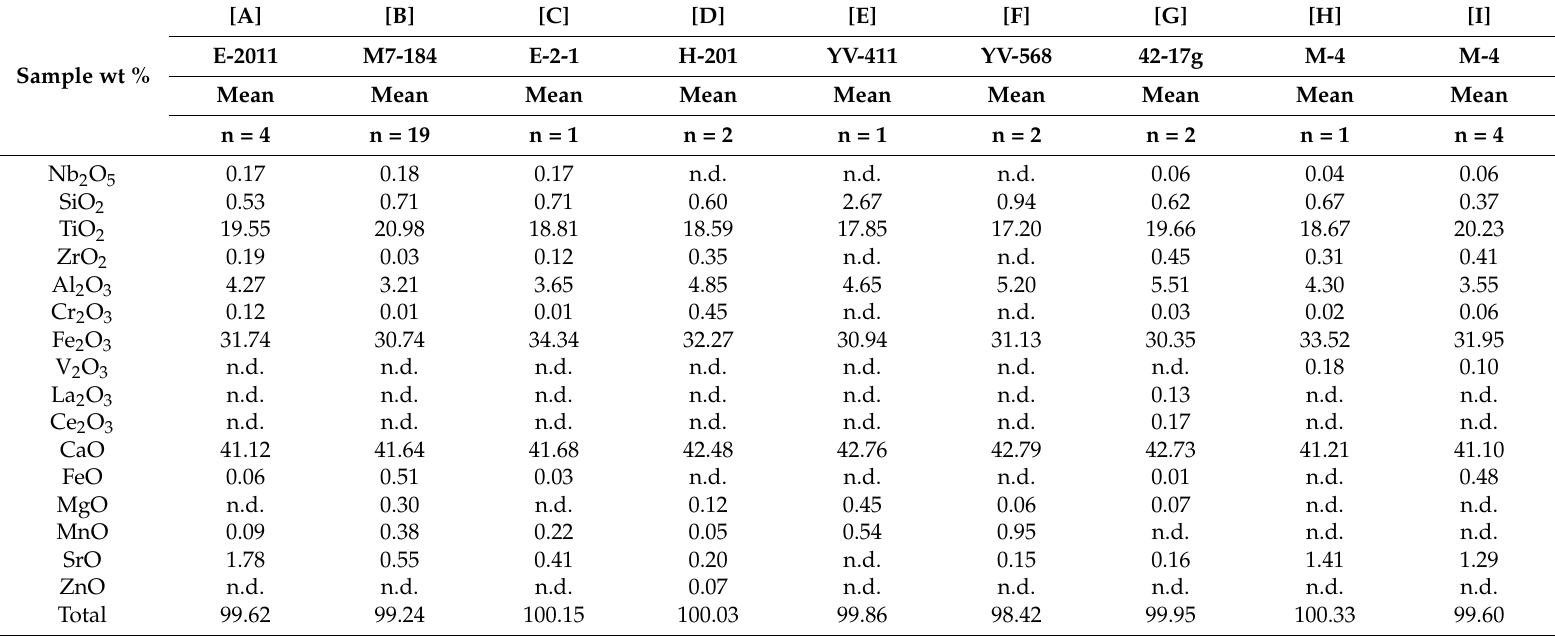
Table 4. The chemical composition of sharyginite from different localities-literature